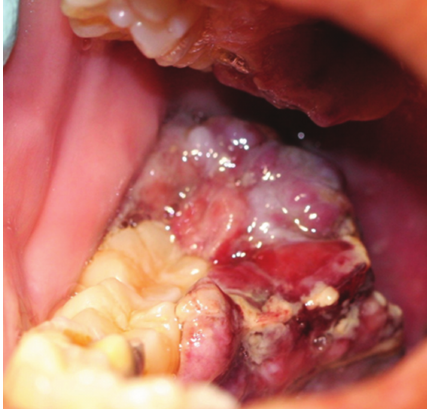
Figure 3: Exophytic oral HIV-KS lesion on the lower right retromolar area extending into the oropharynx in a 29-year-old female patient with a CD4+ T-cell count of 49cells/mm 3 . The patient died six weeks after her oral HIV-KS